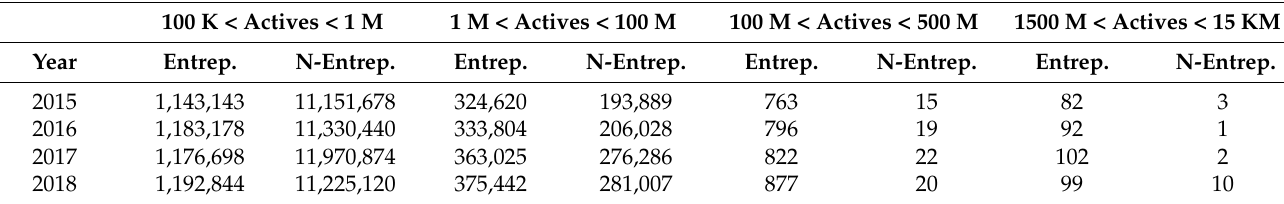
Table 7. Distributions of entrepreneurs by wealth interval over the time.